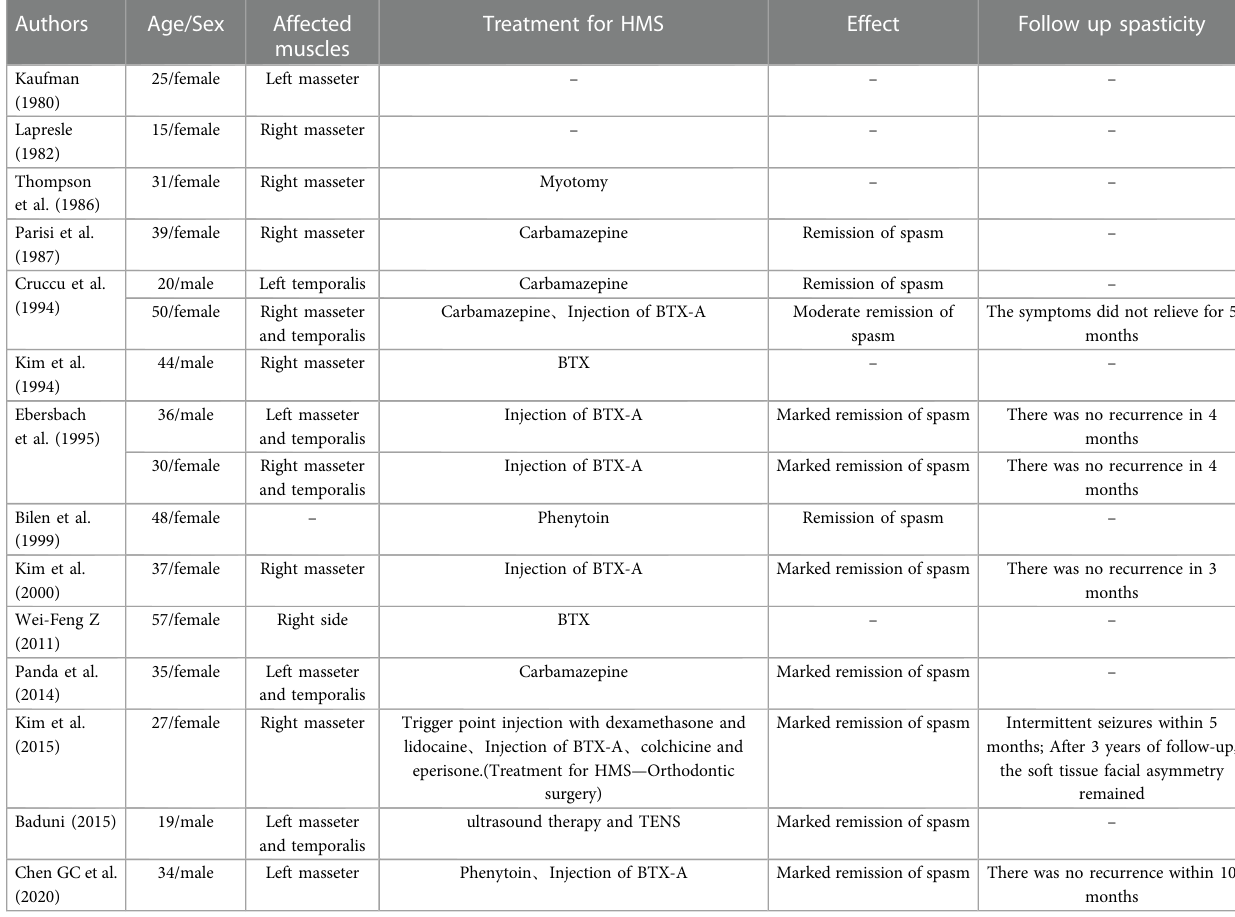
TABLE 1 Review of 16 cases with PRS accompanied with